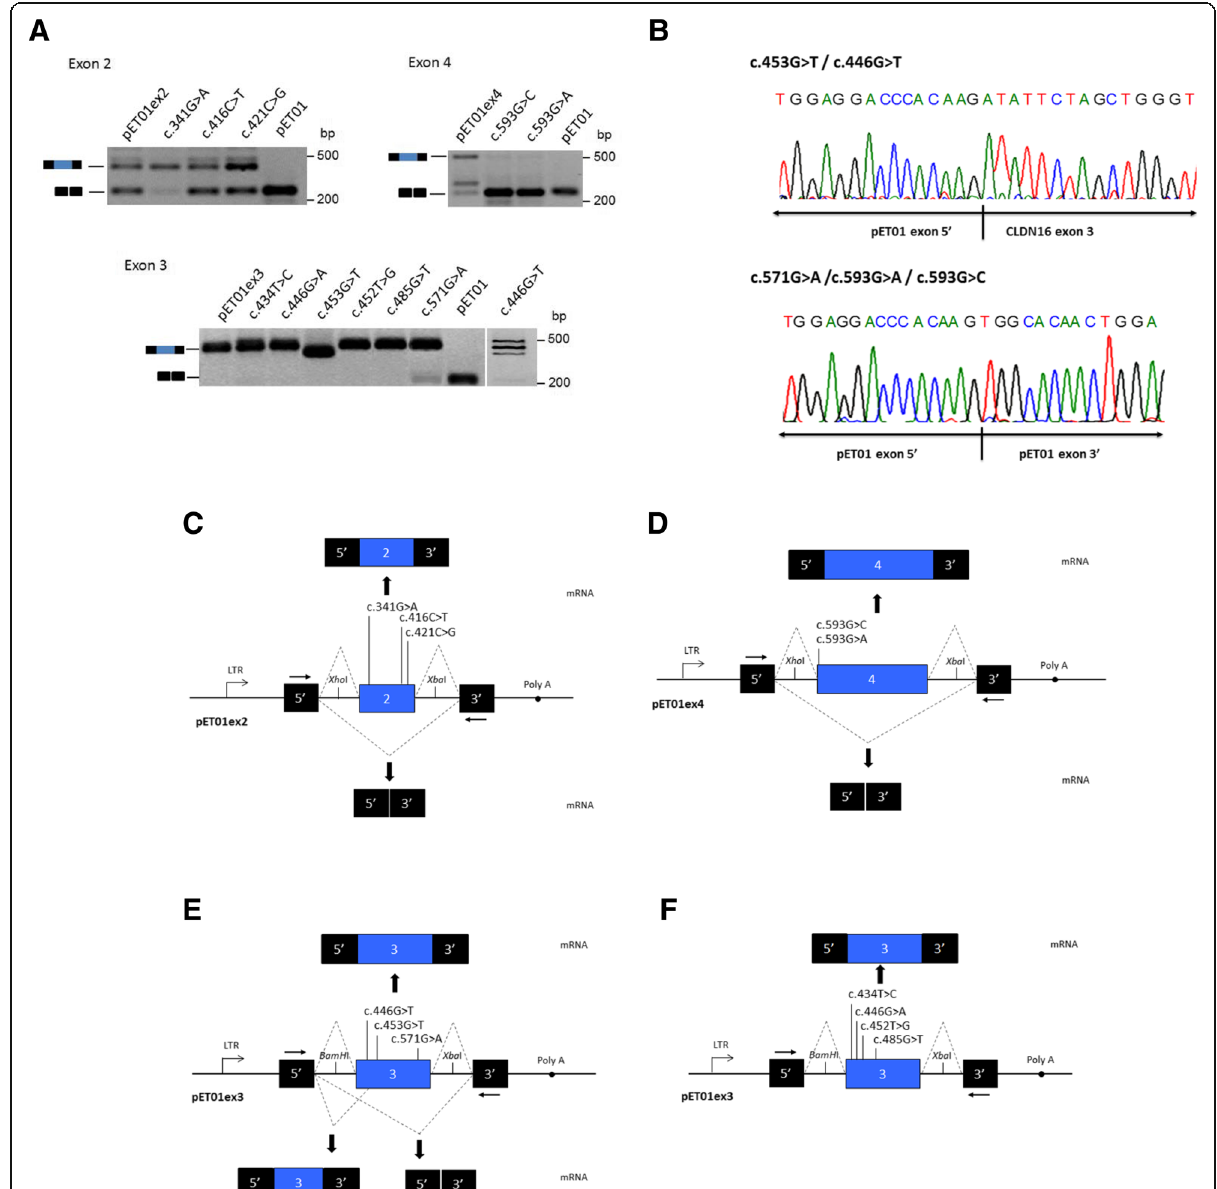
Fig. 3 Minigene assay of CLDN16 exonic mutations revealed altered pre-mRNA splicing. a RT-PCR fragments produced by minigenes and separated by agarose gel electrophoresis. Wild-type and mutant pET01ex2, pET01ex3 and pET01ex4 constructs were transfected into COS7 cells, and the mRNAs were analysed as described in Material and Methods. All assays were performed in triplicate. The identities of the RT-PCR products are illustrated schematically on the left of each panel. b Electropherograms of anomalous RT-PCR fragments produced by minigenes containing the mutations indicated. c-f Schematic representation of minigene splicing in the presence and absence of mutations. The location of mutations is indicated. Mutations c.453G>T and c.446G>T activate a cryptic acceptor splice site internal to exon 3 that induces inclusion of a truncated exon 3. Mutation c.571G>A produced a major band corresponding to the normally spliced transcript together with a minor band that correspond to skipping of exon 3. Both c.593G>C and c.593G>A inactivate the splice site and result in exon 4